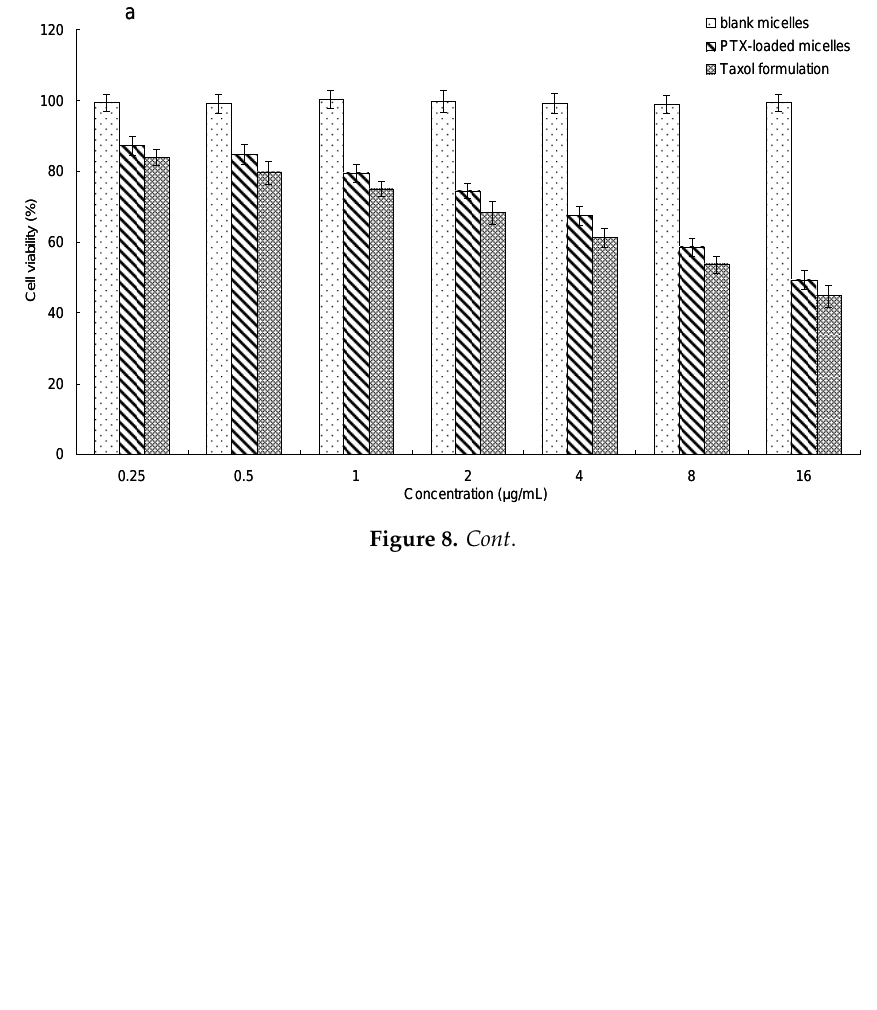
Figure 7. Release of PTX from PTX-loaded mPEG-CS(SH)-CHO micelles under different levels of glutathione (GSH).